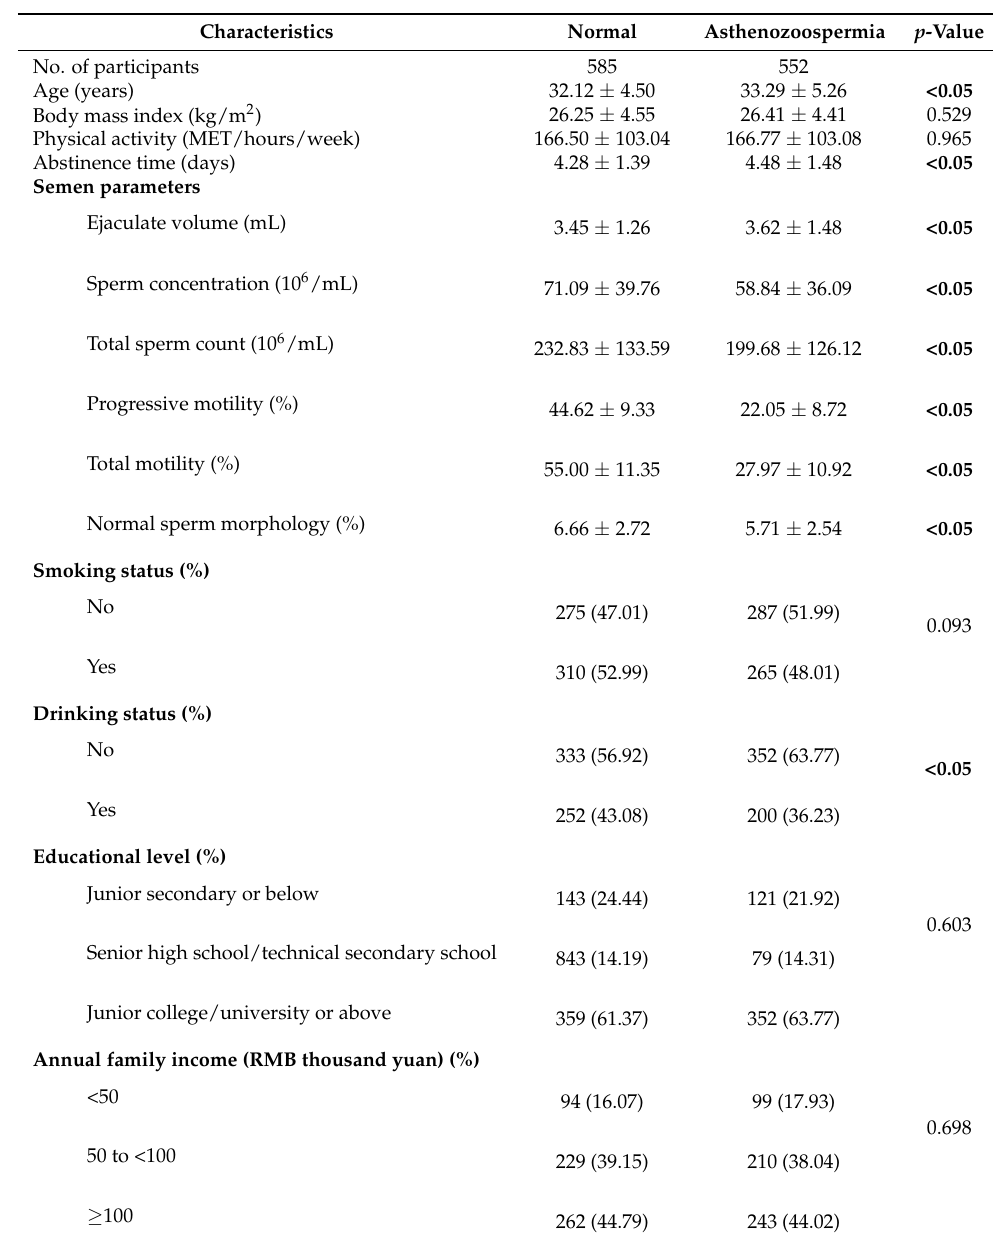
Table 1. Characteristics of participants according to asthenozoospermia status.